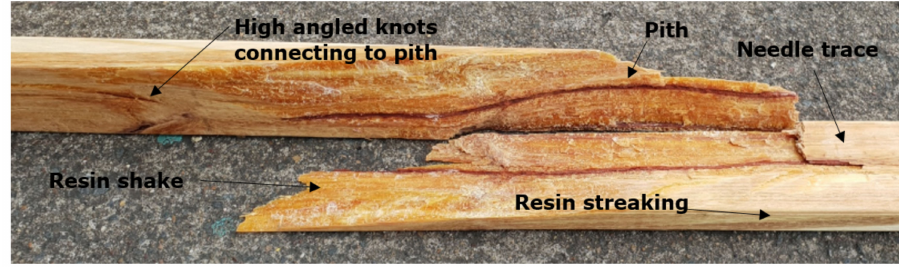
Figure 1. Example of out-of-grade PEE × PCH and its